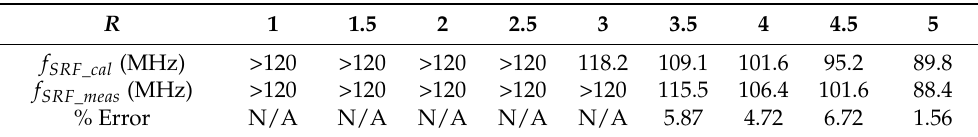
The impedance (real and imaginary) of the elliptical planar inductor calculated from the proposed model was compared with measured values from the impedance analyzer over the frequency range of 20 Hz to 120 MHz. The calculated and measured impedance results are shown in Figures 12b and 13a. In both Figure 13a,b, the real part of the impedance is shown with solid lines, whereas the imaginary part is shown with dotted lines. It can be observed from Figures 12b and 13a that the real and imaginary impendence profiles for both the calculated and measured results of the elliptical inductors are similar.